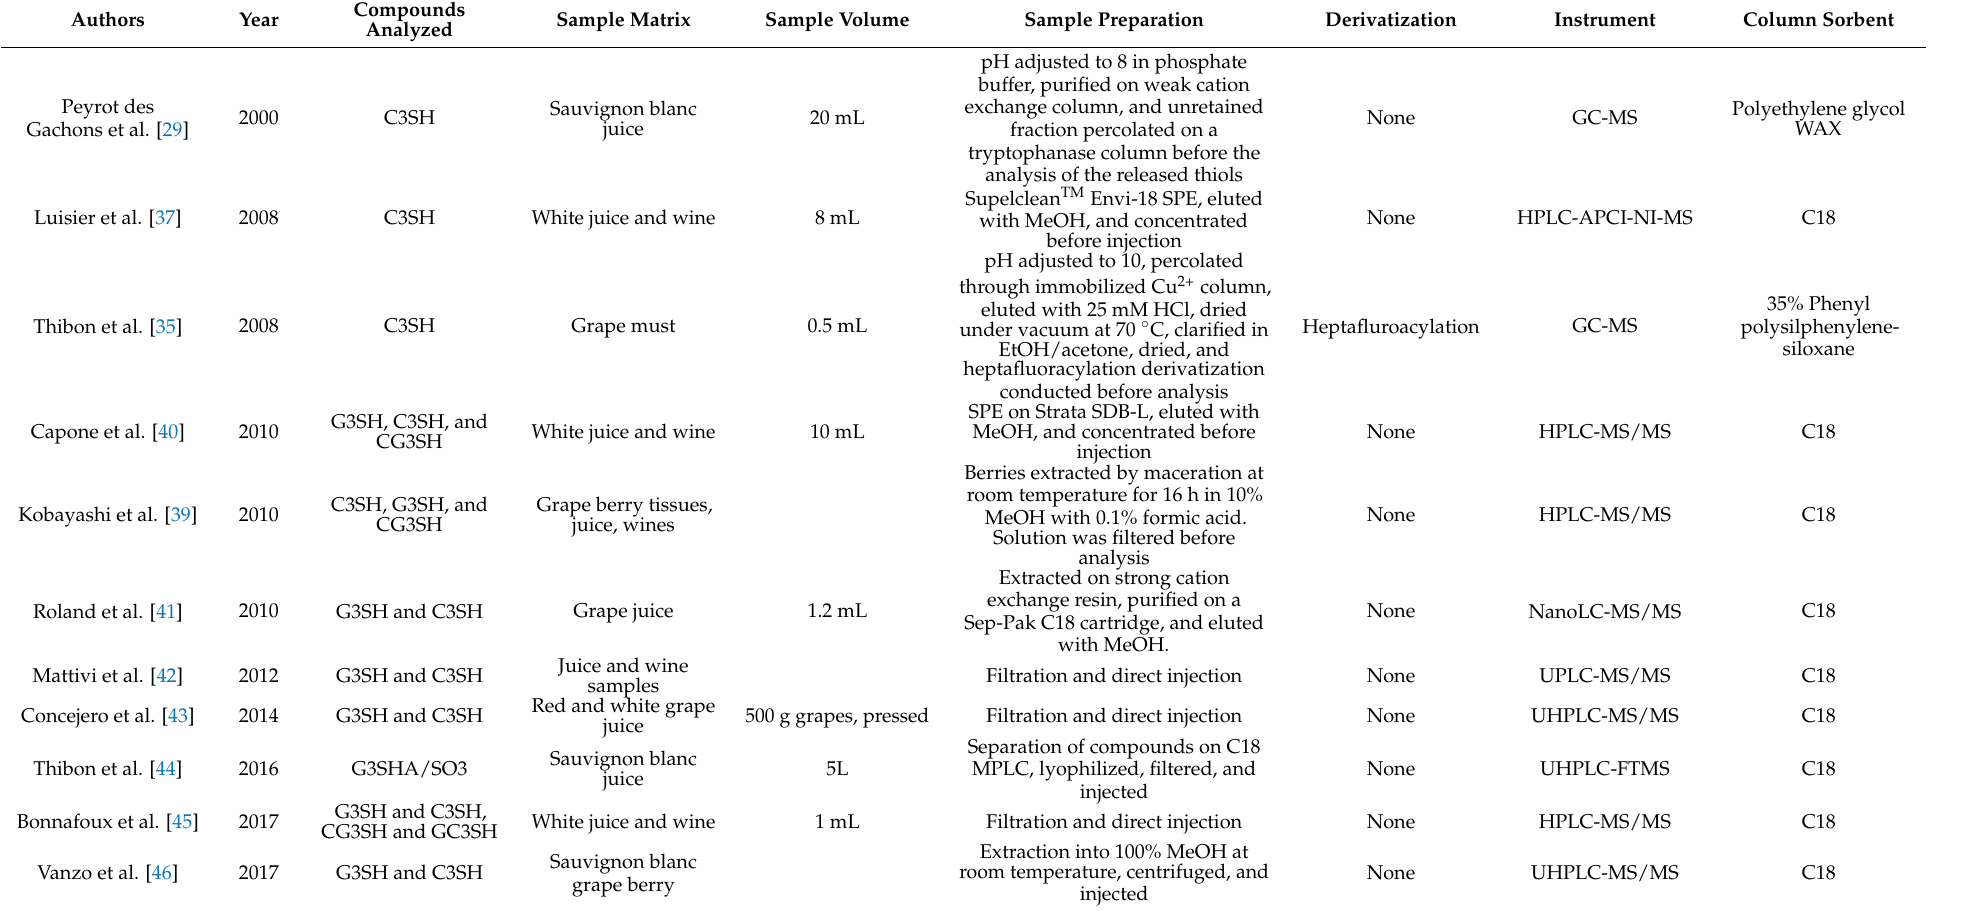
Table 2. Summary of sample preparation and methods for the analysis of thiol precursors in oenologically relevant